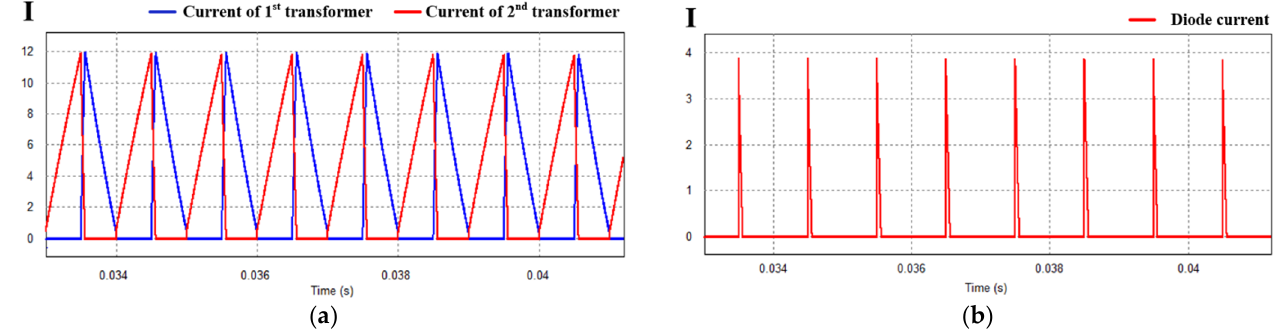
Figure 13. Converter characteristics. ( a ) Transformer and ( b ) diode current converter.